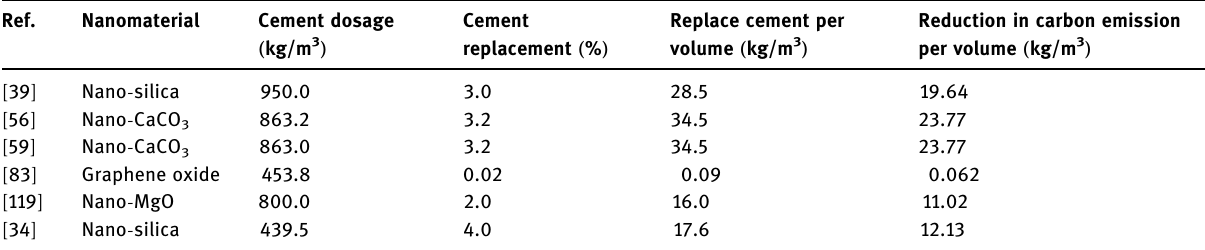
Table 2: Nanomaterial replacement to reduce carbon emission